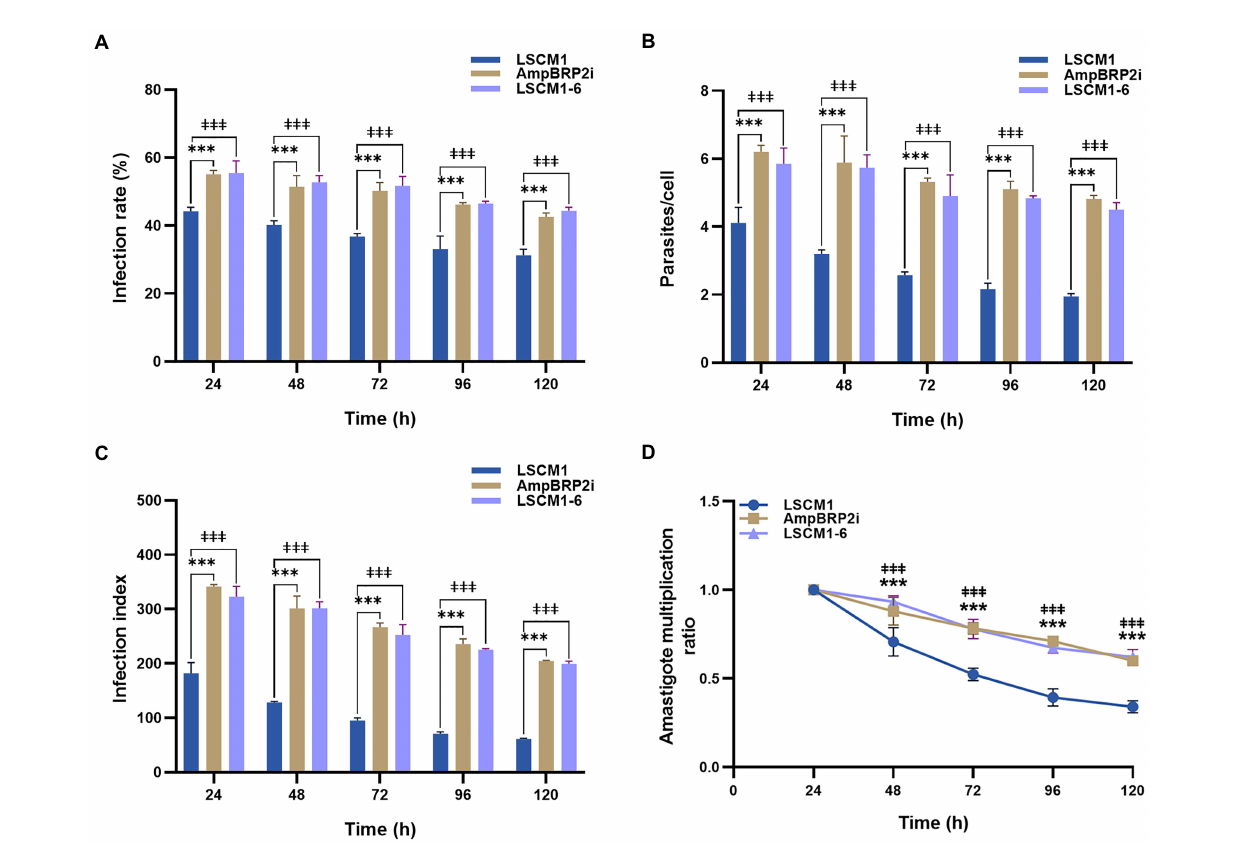
FIGURE 4 PEMs were infected using stationary phase promastigotes after 120 h of culture at a multiplicity of infection (MOI) = 1:10. (A) Percentage of infected cells measured from 24 to 120 h post-infection. (B) Average number of parasites per macrophage. (C) Infection index calculated by multiplying the percentage of infected macrophages by the average number of parasites per macrophage. (D) Amastigote multiplication ratio calculated from the average number of intracellular amastigotes at T x divided by the average number of intracellular amastigotes at T 0 (Chanmol et al., 2019). Results are expressed as the means±SD from three different experiments run in duplicate. Statistically significant differences between LSCM1 and AmpBRP2i are indicated as *** = p < 0.001; between LSCM1 and LSCM1-6 are indicated as ǂǂǂ = p <